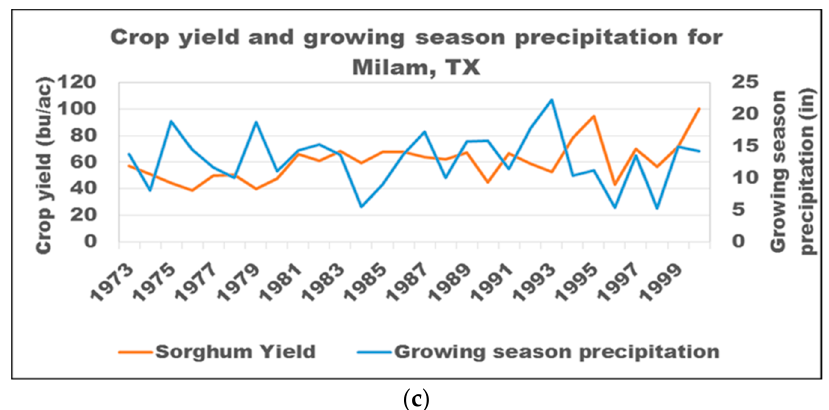
Figure 8. Relationship between growing season precipitation and crop yield for ( a ) Coryell County, ( b ) Bosque County, and ( c ) Milam County. Table 3. Di ff erences in sorghum yield between average growing season total precipitation (for years 1973–2000) and years showing high growing season total precipitation (column 2) and years nearby high growing season total precipitation (column